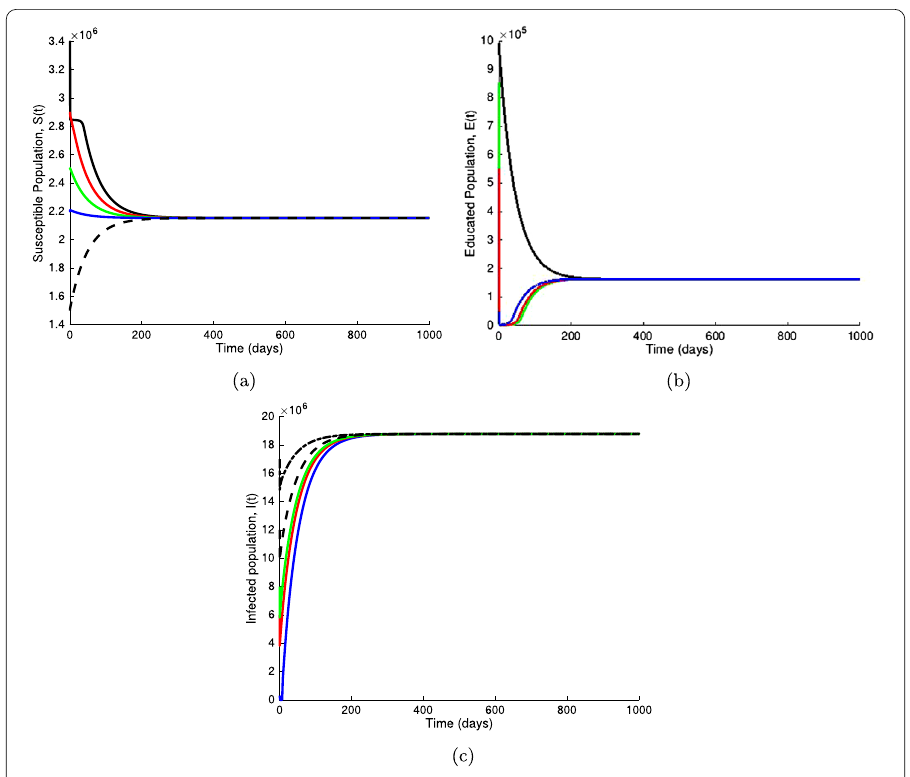
Figure 5 Global stability of the disease-endemic equilibrium when R E > 1. ( a ): global stability of the disease-endemic equilibrium for the susceptible population. ( b ): global stability of the disease-endemic equilibrium for the educated population. ( c ): global stability of the disease-endemic equilibrium for the jigger-infested population. The used parameter values are available in Table